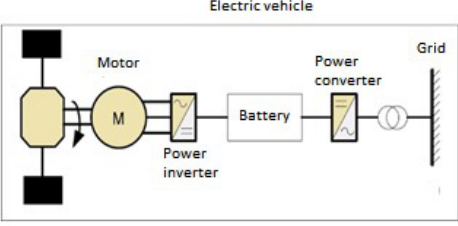
Figure 5. Electric vehicle scheme.